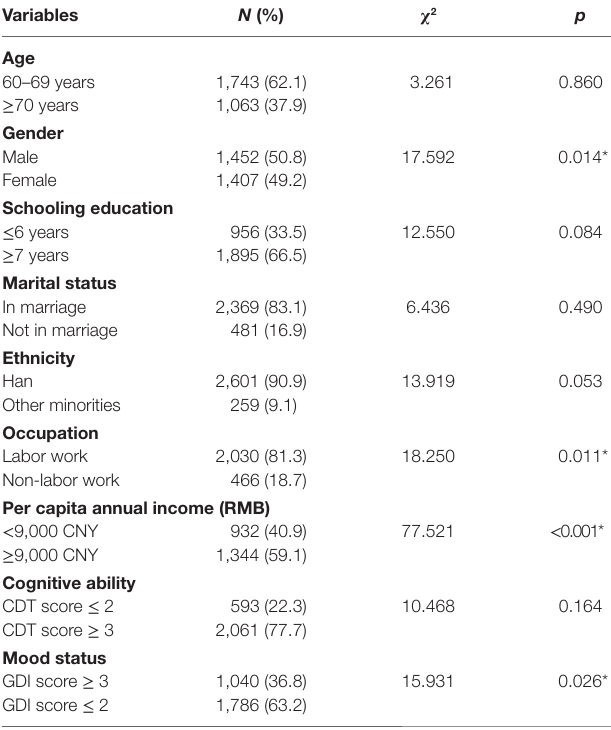
Table 1 | group comparisons of overall dementia literacy ( N = 3,007).